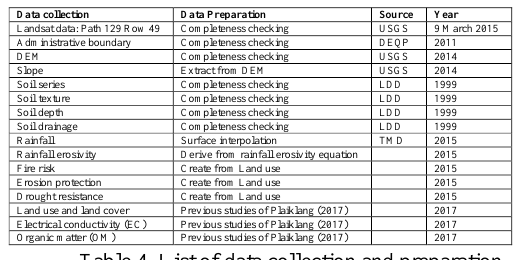
Table 6. Quantitative scores and qualitative classes of vegetation indicators